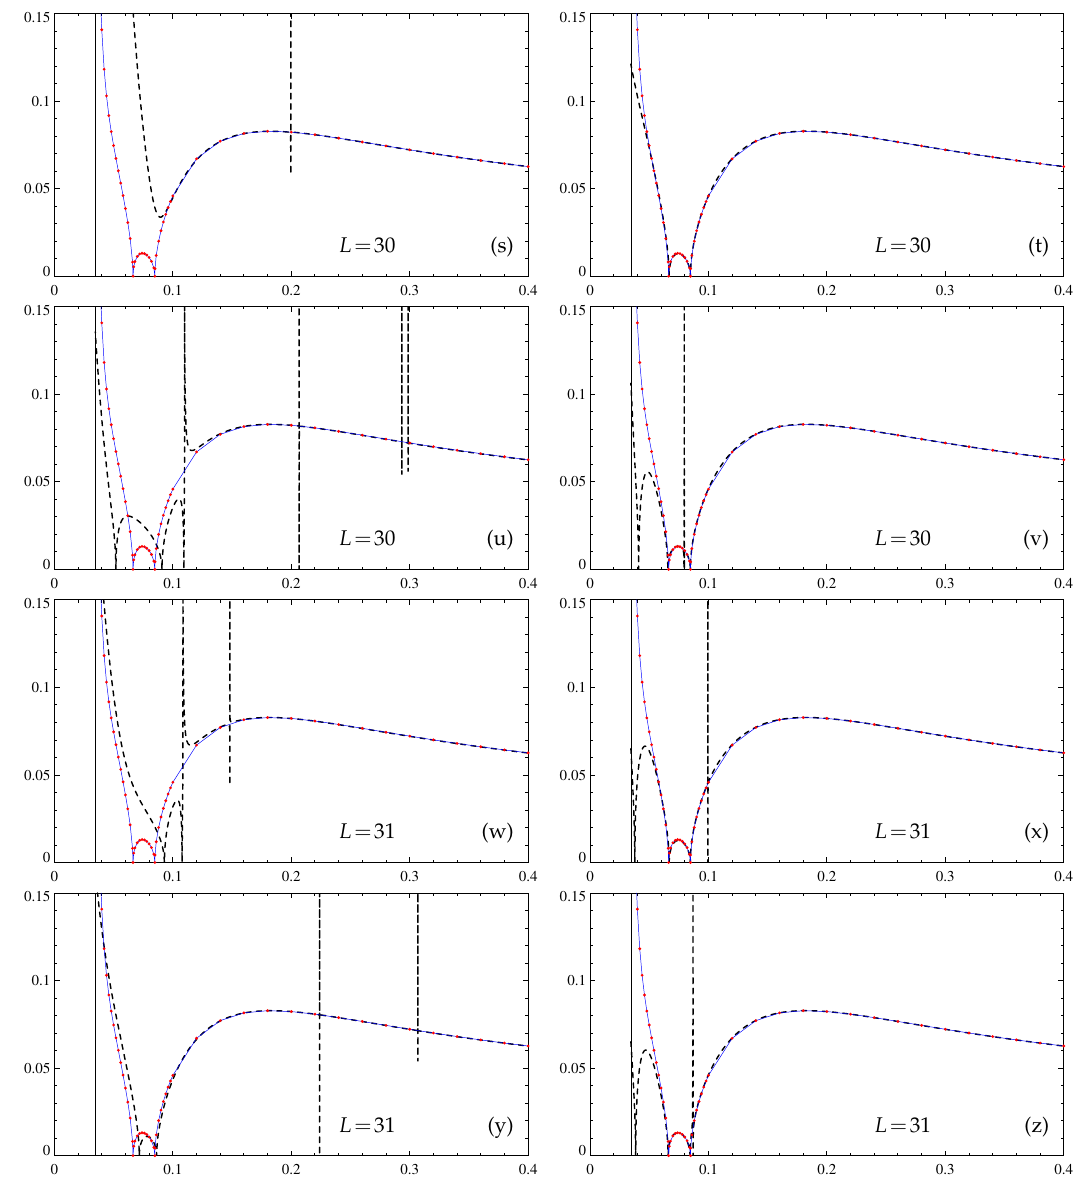
Figure 3. Approximate dependencies of the maximum slow-time growth rates γ α (20) (vertical axis) of large-scale magnetic modes generated by the α -effect on molecular diffusivity η (horizontal axis). Padé approximants [ 2 L 1/2 L ] of α -effect tensor entries are constructed by the algorithm in [5] for the specified L . Resolution of 64 3 ( c , d , g , h , k , l , o , p , s , t , w , x ) and 512 3 ( a , b , e , f , i , j , m , n , q , r , u , v , y , z ) Fourier harmonics, computations with the double (real*8, left panels except ( a )) and quadruple (real*16, right panels and ( a )) precision. Thin solid line: the dependence revealed by computation of γ α at individual η values (red solid circles) by spectral methods (resolution 64 3 Fourier harmonics), wide dashed line: Padé approximants.